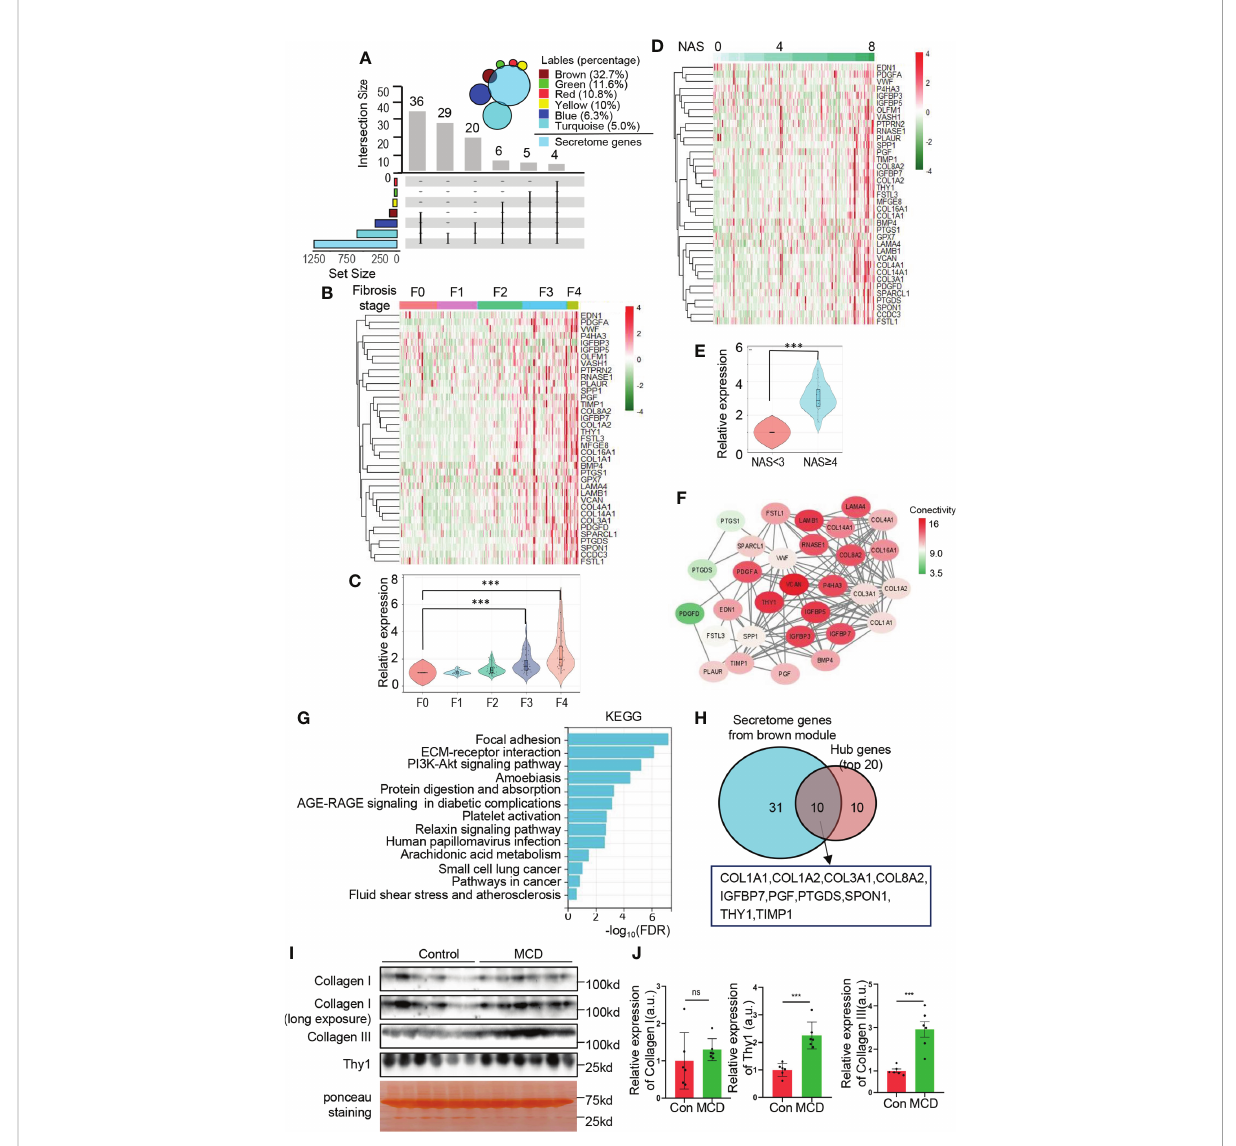
FIGURE 6 Identi fi cation of secretome genes from brown module. (A) Upset plot summarizes the intersection between secretome database and genes of each module. The bar plot represents the intersection gene numbers. The Venn diagram in the top right corner shows the percentage of secretome genes of each module. (B – E) The relative expression of secretome genes from brown module are exhibited with heatmap (B, D) with the corresponding quanti fi cation (C, E) . Heatmaps are normalized by z-score and the columns are arranged according to fi brosis stages (B) and NAS (D) , respectively. Data are represented as means ± SEM. ***adjusted P value < 0.001 or *** P value < 0.001 as indicated by one-way ANOVA test (C) or two-tailed Student ’ s t test (E). (F) Network of intersection genes between brown module and secretome database. Colors of the circle are proportional to the intramodular connectivity. (G) KEGG analysis with secretome genes from brown module. (H) Venn diagram showing intersection of the top 20 hub genes calculated by MCC and secretome genes from brown module. (I, J) C57BL/6 mice fed with MCD diet or normal chew diet for 4 weeks to establish NASH mice model. The protein levels of collagen I, III and Thy1 in serum were determined by Western blots (I) with quanti fi cation (n=6) (J) . Data are represented as means ± SEM. ns, not signi fi cant; *** P <